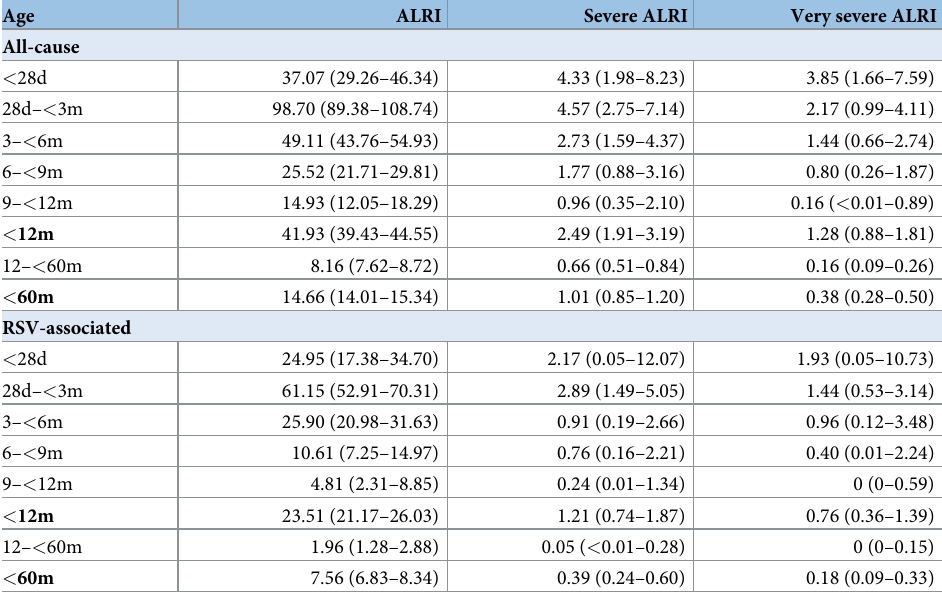
RSV = respiratory syncytial virus; ALRI = acute lower respiratory infection. Numbers are presented as hospitalisation rate per 1000 children, with 95% confidence intervals.